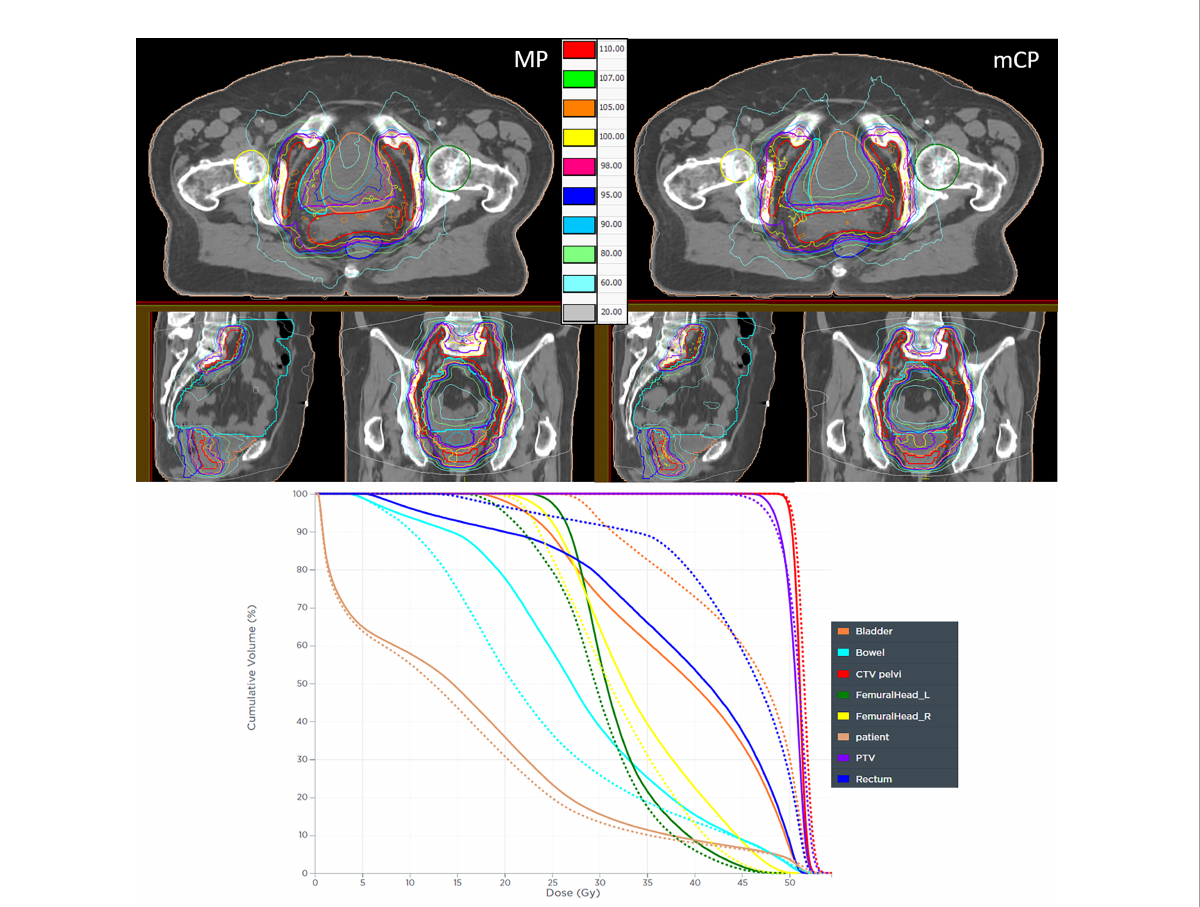
FIGURE 3 Dose distribution comparison of a manual plan (MP) and a mCycle plan (mCP). The isodose color legend is reported while the contoured structures are CTV (red), PTV (purple), rectum (blue), bladder (orange), bowel (cyan), right femoral head (yellow), left femoral head (green), and patient (pink). The DVH curves are reported as solid lines for mCP and dotted lines for MP.